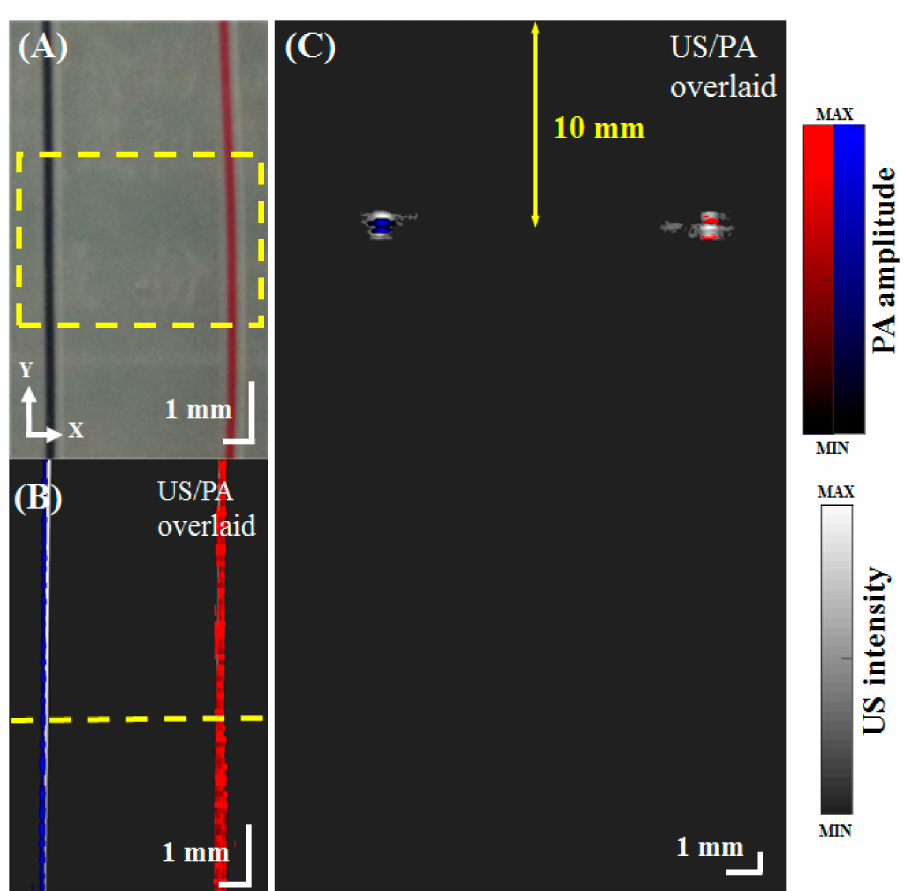
Figure 2. US/PA images of vessel phantoms. ( A ) Image of the tube phantoms filled with red and blue ink to mimic oxygenated and deoxygenated blood. The phantoms were imaged using US/PA within the yellow dashed rectangle (3 mm × 6 mm). ( B ) Overlaid US/PA MAP image (PA850/PA750) of the tube phantoms filled with red and blue ink. The yellow dashed line marks the location of the cross-sectional US/PA B-scan shown in Figure 2C. ( C ) Overlaid US/PA B-scan image of the phantoms at an imaging depth of 10 mm. PA, photoacoustic; US, ultrasound; PA750, PA signal at an excitation wavelength of 750 nm; PA850, PA signal at an excitation wavelength of 850 nm; and MAP, maximum amplitude